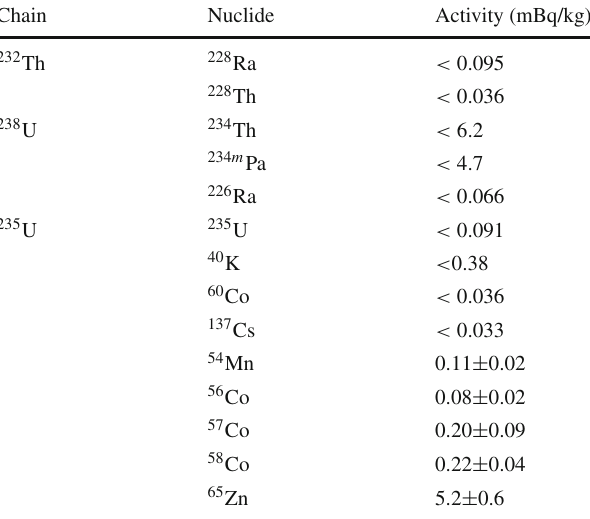
Table 2 Activity of internal radioactive contaminations in the purified granular zinc measured with a ULB-HPGe detector. Activity values are present in units of mBq/kg, and limits are at 90% CL Chain Nuclide Activity